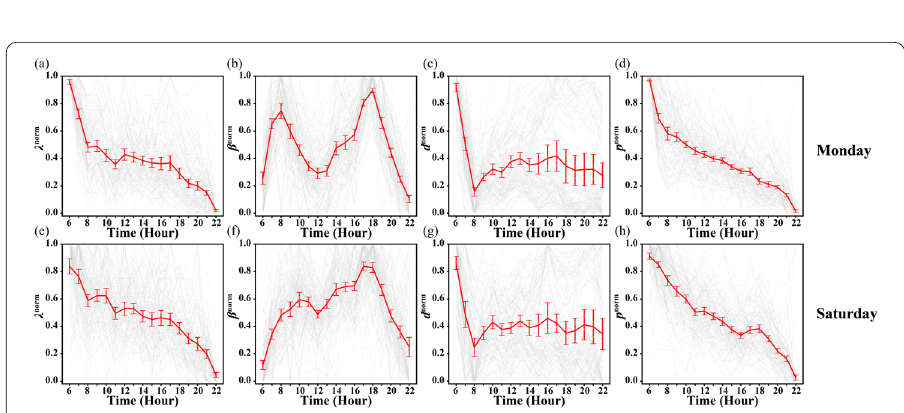
Figure 6 Temporal features of index values. The red line denotes the average index value and the light gray line denotes the index value of each SDN. ( a ), ( c ) Coupling strength λ norm ; ( b ), ( f ) Speed ratio β norm ; ( c ), ( g ) Average trip distance d norm ; ( d ), ( h ) Fraction of trips from ordinary zones p